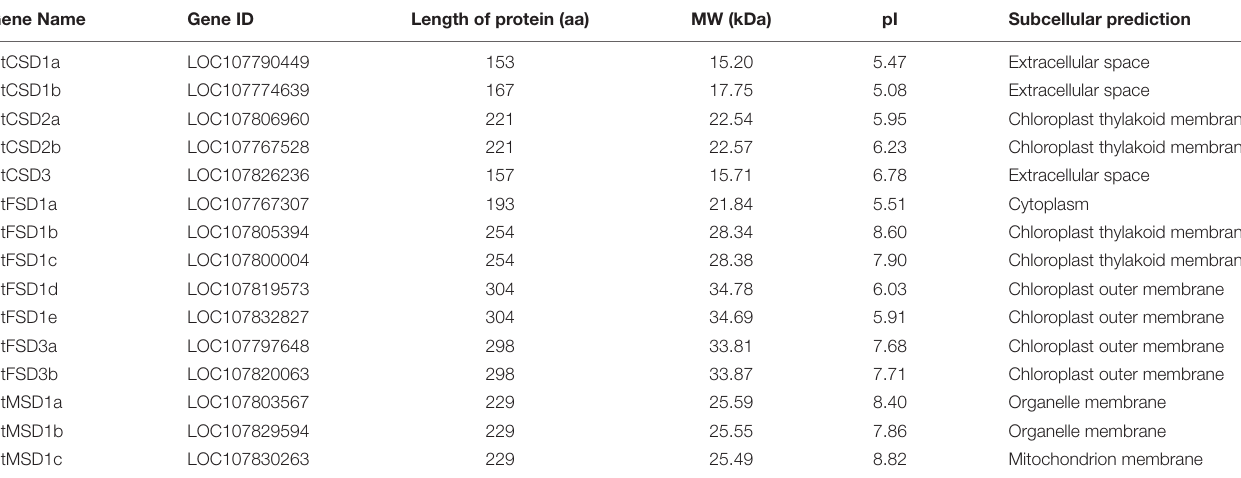
TABLE 1 | The data of 15 NtSOD genes identified in tobacco